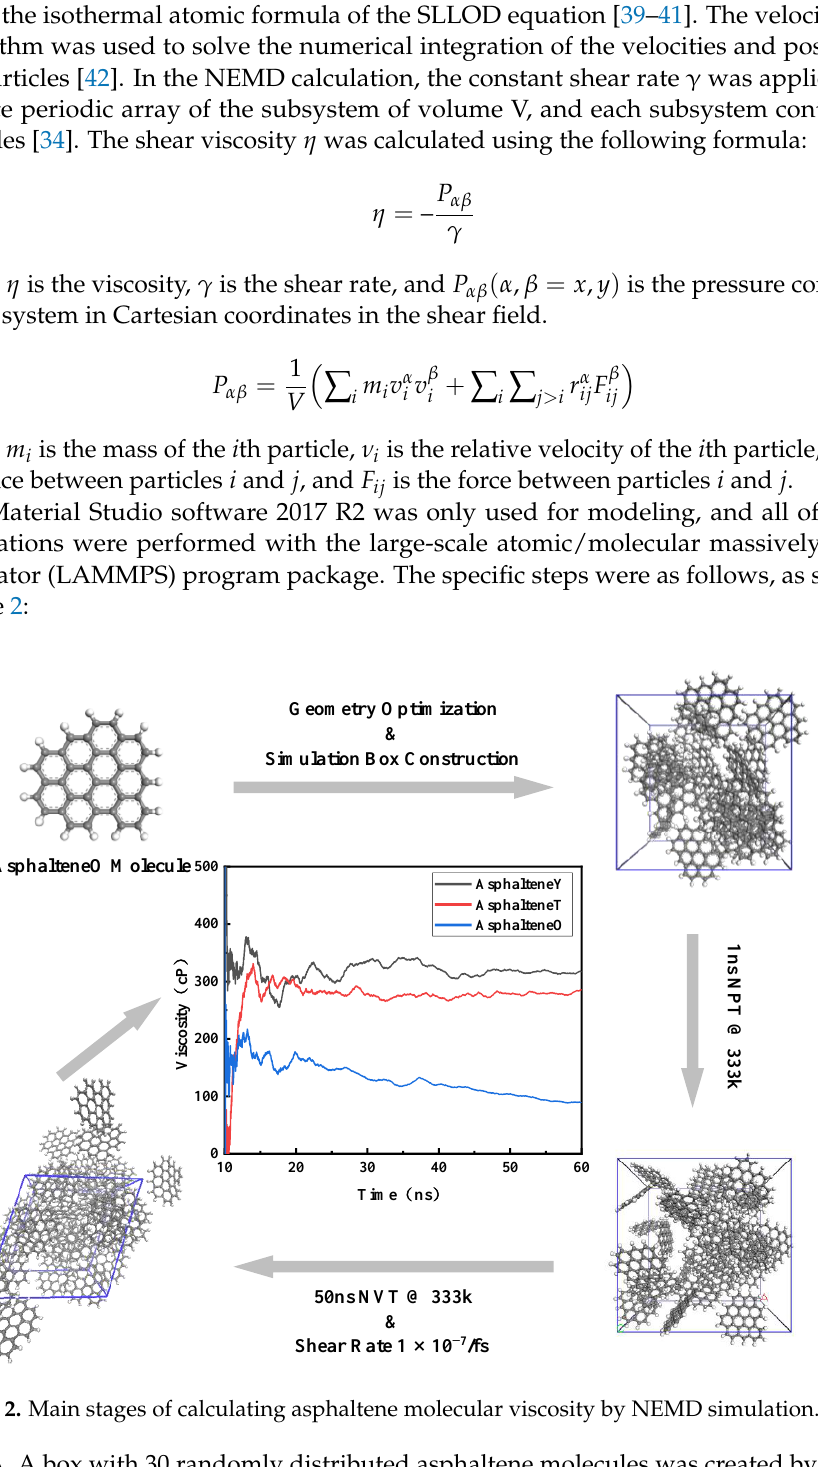
Figure 2. Main stages of calculating asphaltene molecular viscosity by NEMD simulation. A. A box with 30 randomly distributed asphaltene molecules was created by Material Studio, and the initial density of the system was set to 0.6 g/cm 3 . This study used the COMPASS force